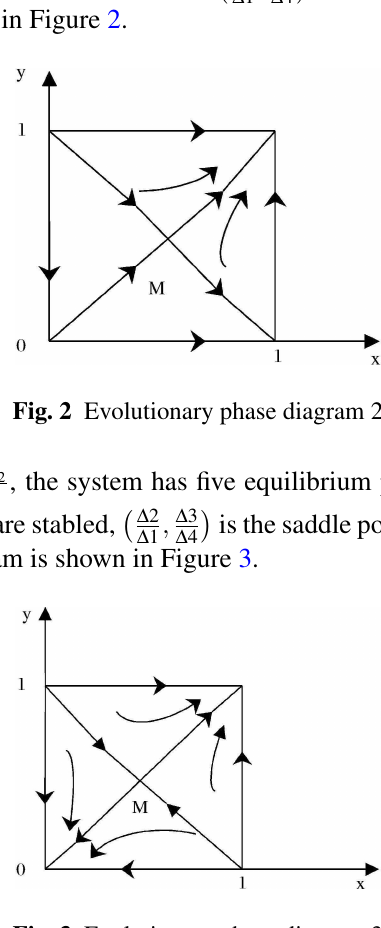
Fig. 3 Evolutionary phase diagram